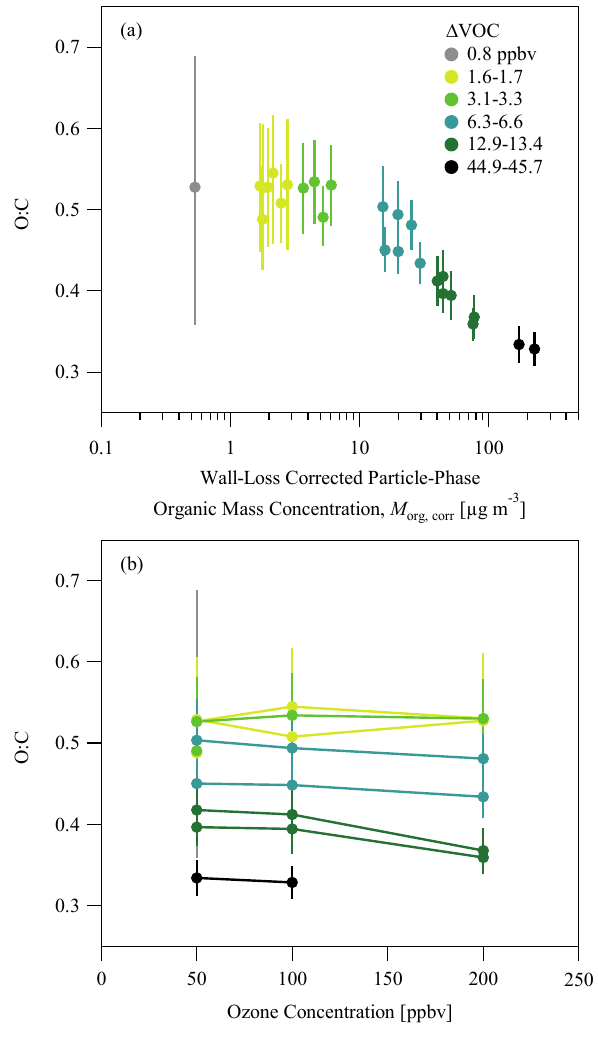
Fig. 6. Oxygen-to-carbon elemental ratios of particle-phase SOM produced by β -caryophyllene ozonolysis for (a) increasing particle- phase organic mass concentration and (b) increasing ozone concen- tration. The elemental ratios were determined from the particle- phase high-resolution mass spectra (Aiken et al., 2007, 2008; Chen et al., 2011). Error bars represent the one-sigma measurement pre- cision (Chen et al., 2011). Data are colored by the reacted concen- tration of β -caryophyllene.